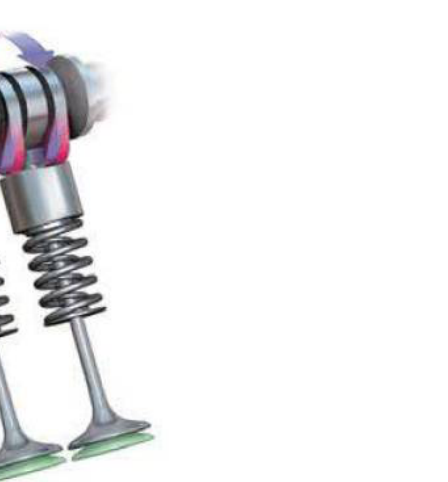
Figure 7. Diagram of the VVT-i [39].